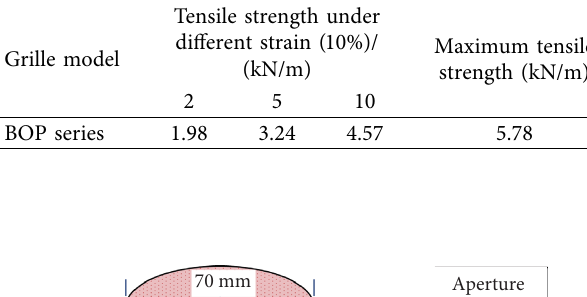
Table 2: Basic information of selected geogrid. Grille model